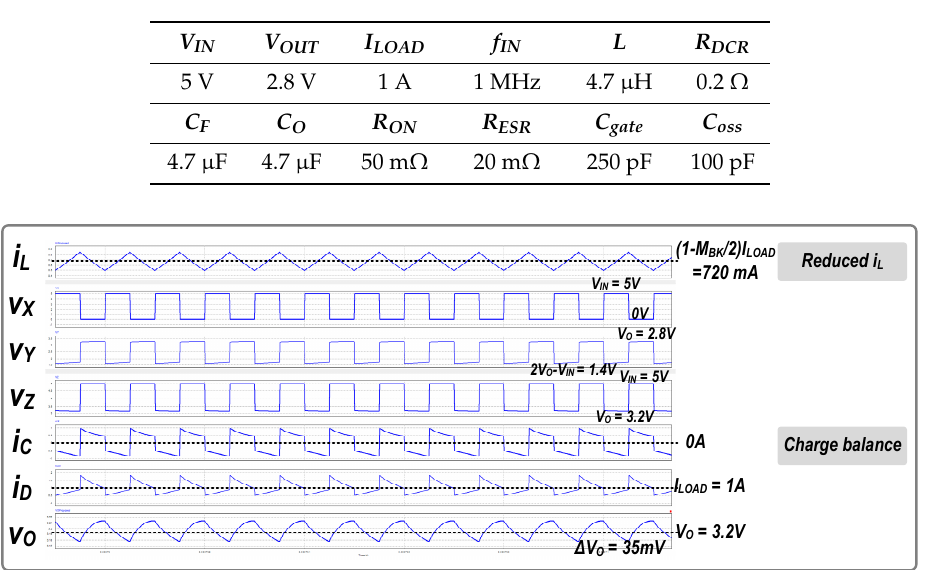
Figure 12. Simulation waveforms of a buck converter with ETM.